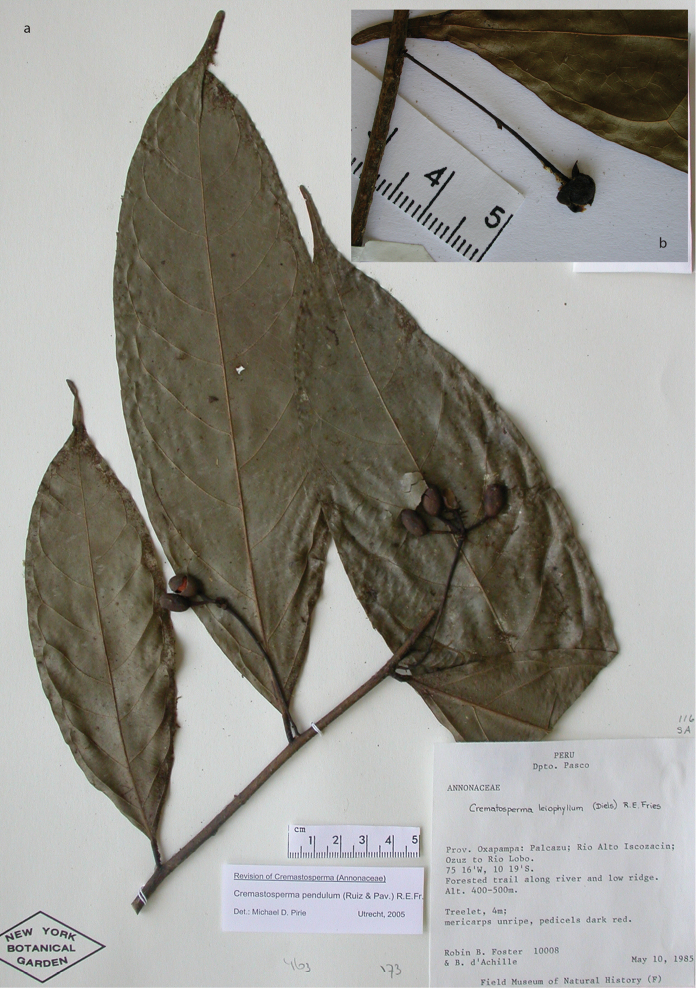
Cremastospermapendulum (Ruiz & Pav.) R.E.Fr. a fruiting specimen b flower bud (aFoster & d’Achille 10008bFoster 9842).